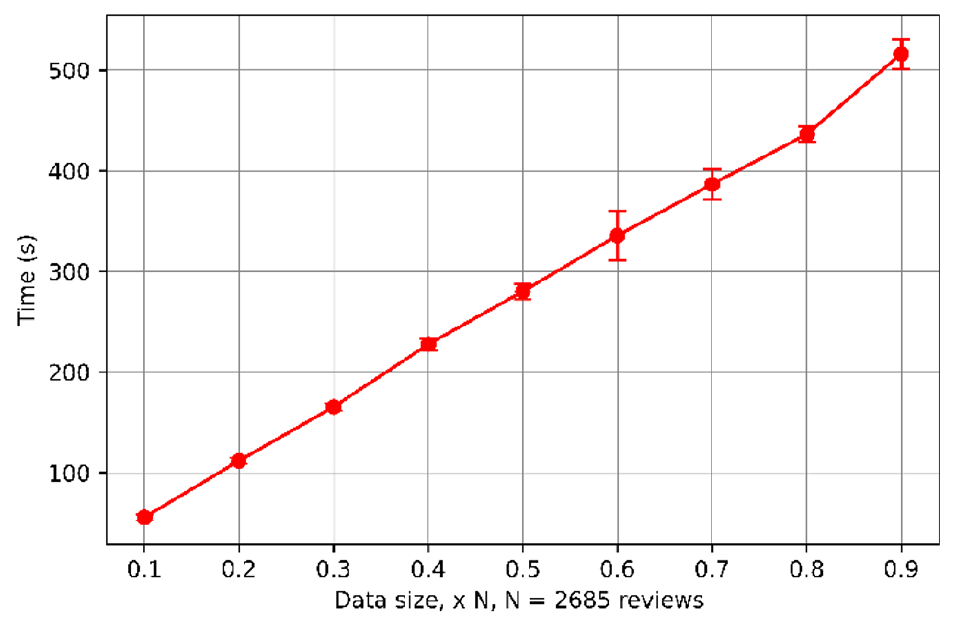
Figure 9. TopicDiff-LDA computing time as a function of the segmented review amount. On the graph, each dot indicates the time averaged over 10 random samples of the given size, and the bars show the standard error.